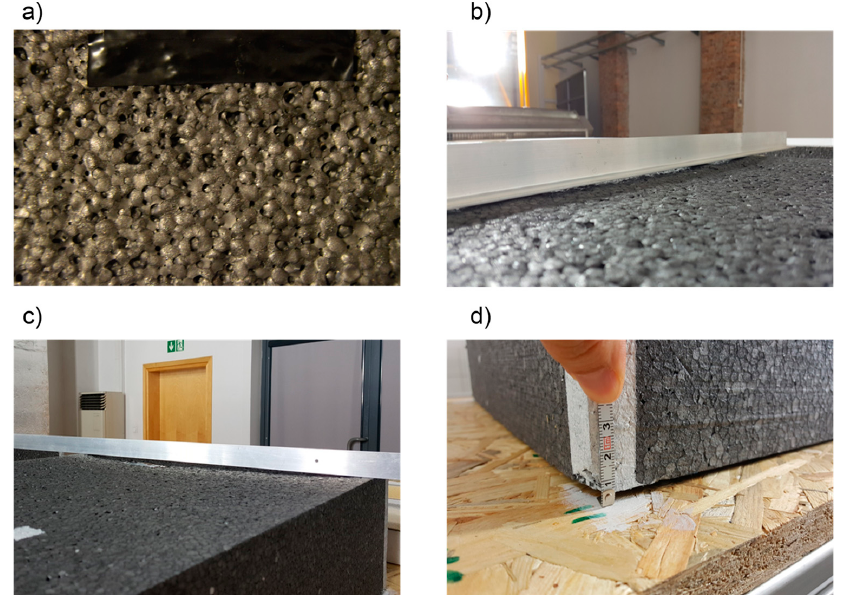
Figure 16. Damage to panels B. ( a ) loss of polystyrene granules in effect of exceeding the softening temperature, ( b ) and ( c ) deformation of the panel due to the exposure to artificial sun, ( d ) panel edge raised away from the ground.